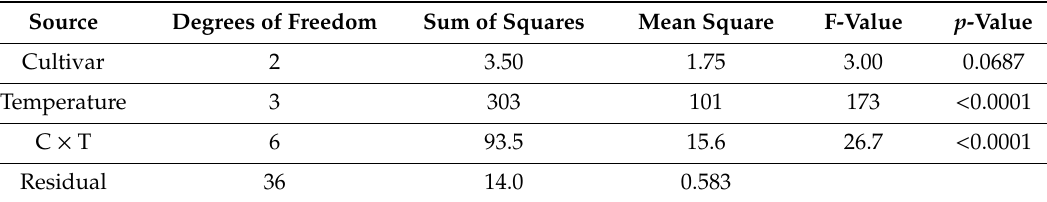
Table A5. Analysis of variance for photosynthetic rates measured at 200 µ mol mol − 1 C i for three soybean cultivars grown at 25 ◦